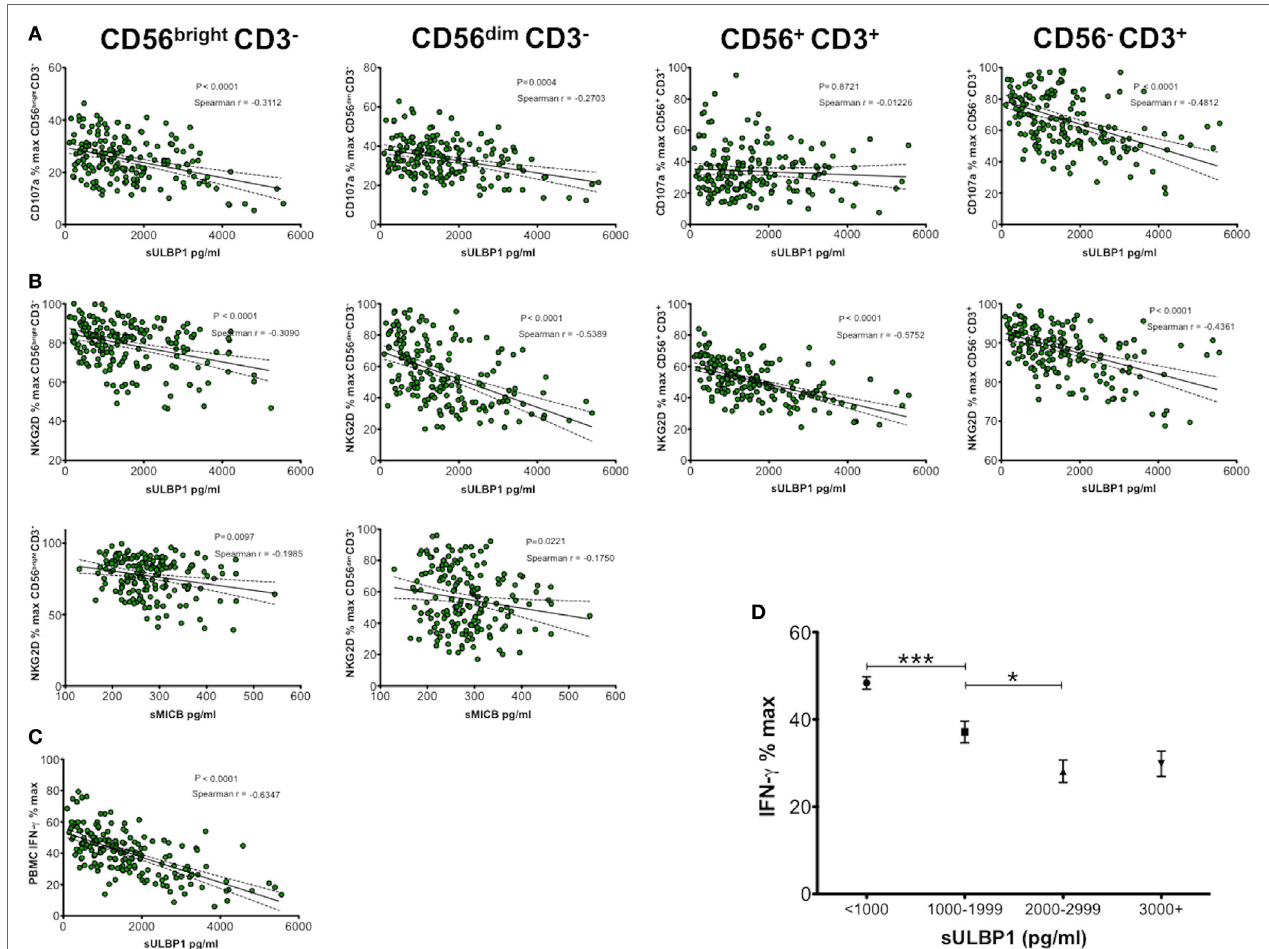
FigUre 2 | Soluble NKG2D ligand (sNKG2DL) effect on NK group 2, member D (NKG2D) and CD107a expression by CD56 bright CD3 − , CD56 dim CD3 − natural killer (NK) cells, CD56 + CD3 + NKT cells, CD56 − CD3 + T cells, and IFN- γ production by peripheral blood mononuclear cells (PBMCs). (a) Correlation and linear regression analysis of sULBP1 concentration effect on CD107a expression. (B) Correlation and linear regression analysis of sULBP1 and sMICB concentration on NKG2D expression. (c) Correlation and linear regression analysis of sULBP1 effect on production of IFN- γ by PBMCs. PBMCs were incubated with 50% cord blood plasma (CBP) ( n = 181) or media only for 48 h and then stimulated with PMA and ionomycin. IFN- γ in culture supernatants and sNKG2DLs in CBP was measured by ELISA and expression of CD107a and NKG2D on the different cell types was measured by flow cytometry. P -values for Spearman r correlations are indicated. (D) Increasing concentration of soluble ULBP1 decreases potential IFN- γ production by NK cells in a dose-dependent manner ( n = 181). Each experiment was repeated with four different PBMC donors and data points represent donor means. Statistical analysis (D) was performed using Mann–Whitney test ± SEM (* P ≤ 0.05 and *** P <